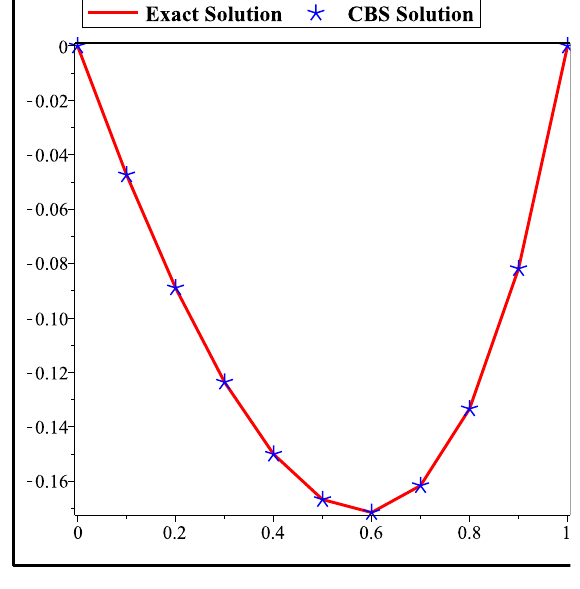
Figure 1. Problem 1 at h = 1